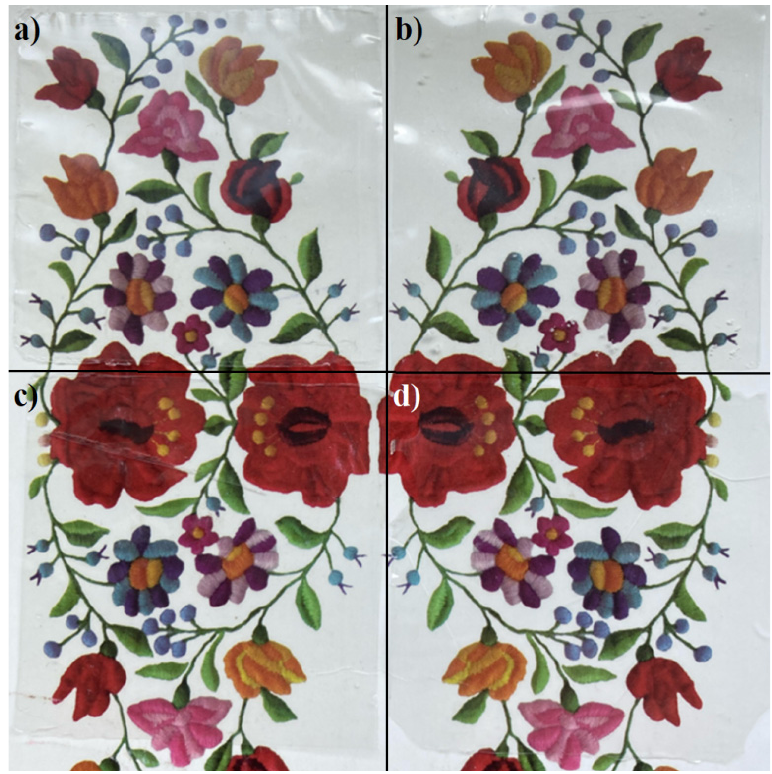
Figure 1. Transparent TPS–CNC films with different compositions: ( a ) 30% sorbitol and 50 wt% CNCs; ( b ) 40% sorbitol and 50 wt% CNCs; ( c ) 30% glycerol and 20 wt% CNCs; ( d ) 40% glycerol and 20 wt% CNCs.